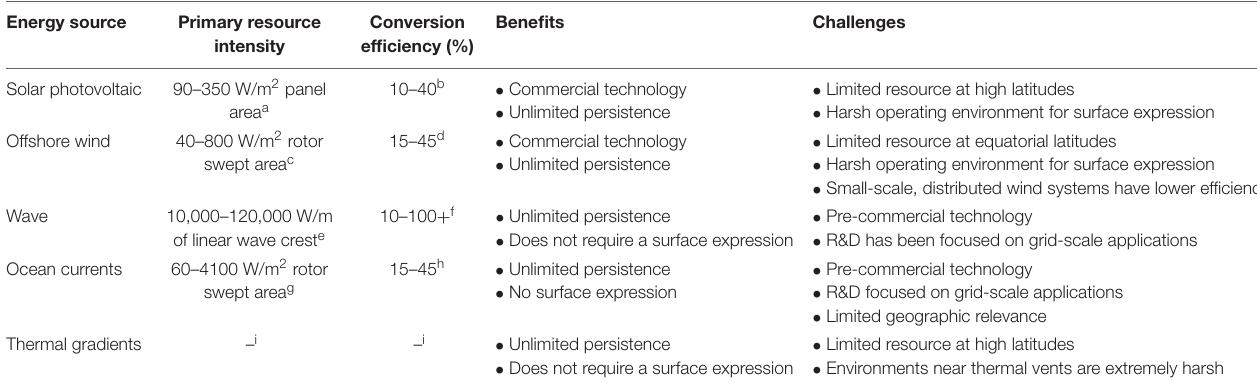
TABLE 1 | Candidate energy sources for AUV recharge and offload